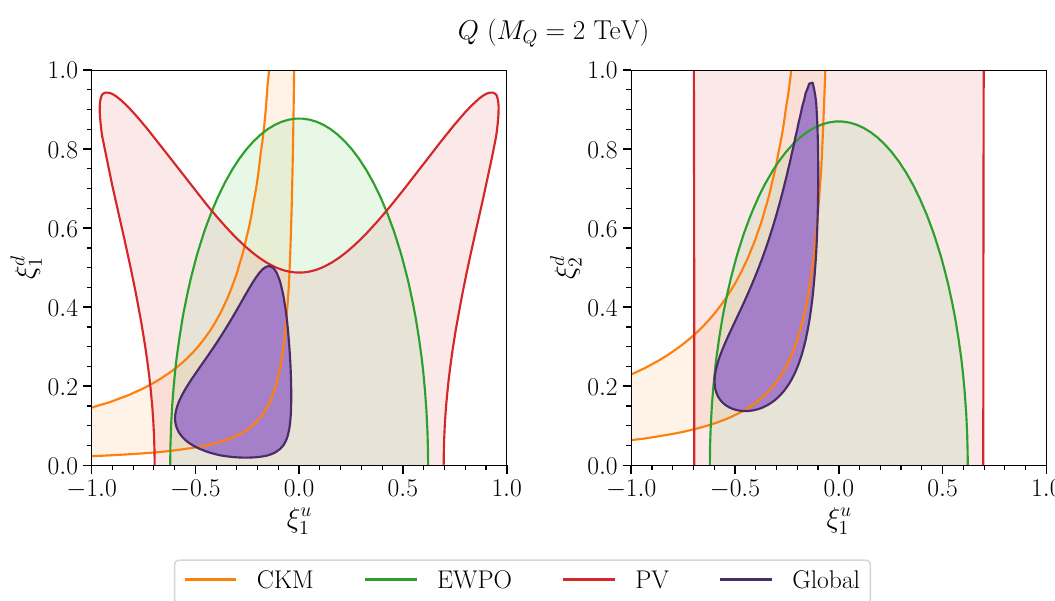
Figure 14 . Preferred regions for the VLQ Q with either couplings to u and d (left) or u and s